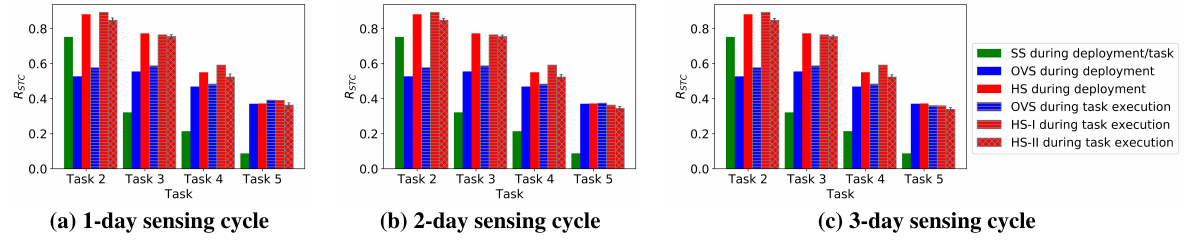
Figure 6. Comparison of the ratio of spatio-temporal coverage between deployment and task execution for different sensor deployment in different